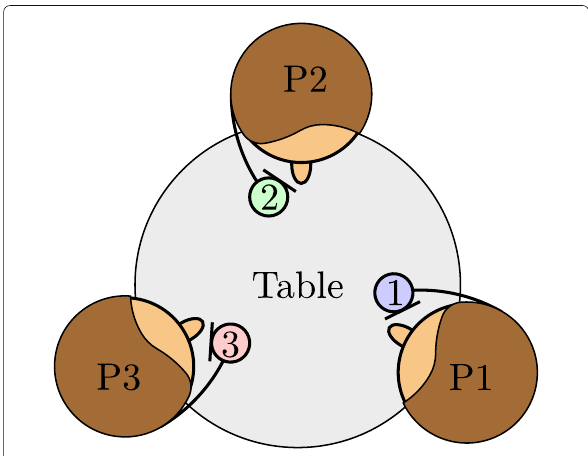
Fig. 1 Investigated meeting scenario with three participants (P1, P2, P3), all wearing a (wireless) headset. For simulation purposes, all persons are represented by a head-and-torso simulator (HATS) with a close-talk microphone placed in front of the